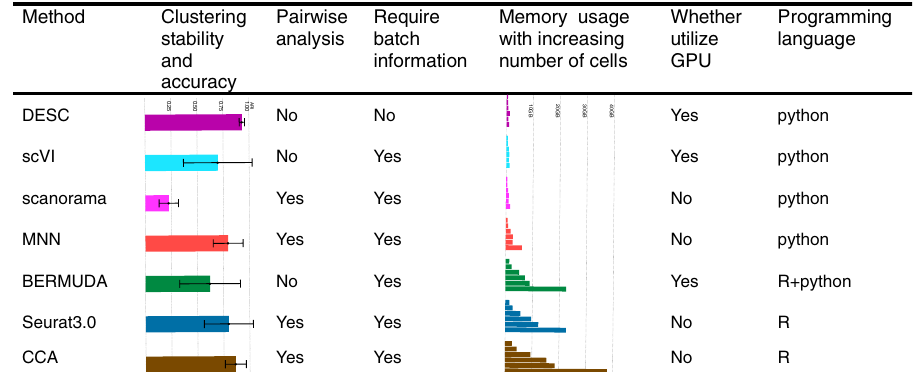
Fig. 10 Comparison with different methods for batch effect removal. The second column was computed based on results shown in Fig. 1e, and the error bar is the standard error of ARI when using different information as batch in analysis. The fi fth column was computed based on results shown in Fig. 9a. For each method, memory usage was shown for 1000, 2000, 5000, 8000, 10,000, and 20,000 cells,